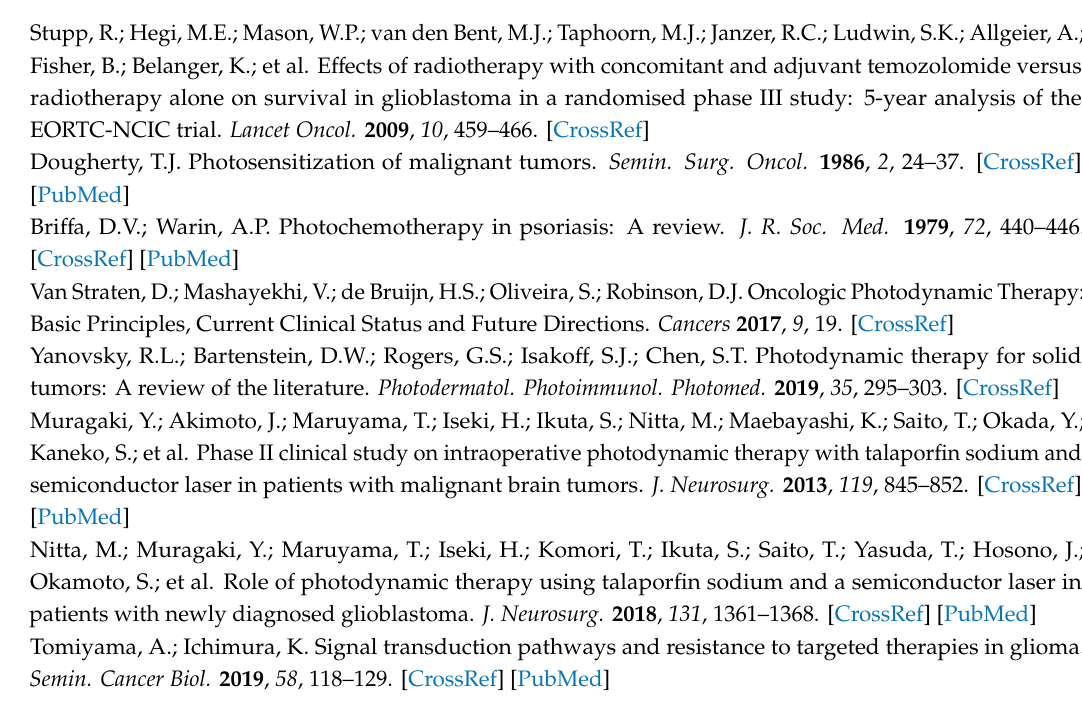
Figure S1: Schematic illustration of in vitro NPe6-PDT mode, Figure S2: Dual knockdown of Bax and Bak completely blocked NPe6-PDT-induced intracellular translocation of AIF and cytochrome c in GBM cells, Figure S3: Trametinib blocked ERK1 / 2 phosphorylation (activation) in NPe6-PDT-R GBM cells by dose-dependent manner of trametinib, Figure S4: Trametinib reversed the resistance against PDT-induced cell death of the glioma stem cells of T98G cells (T98G-GCSs) survived from PDT, Figure S5: The morphological appearance of NPe6-PDT-R cells and their control cells, Supplementary Materials and